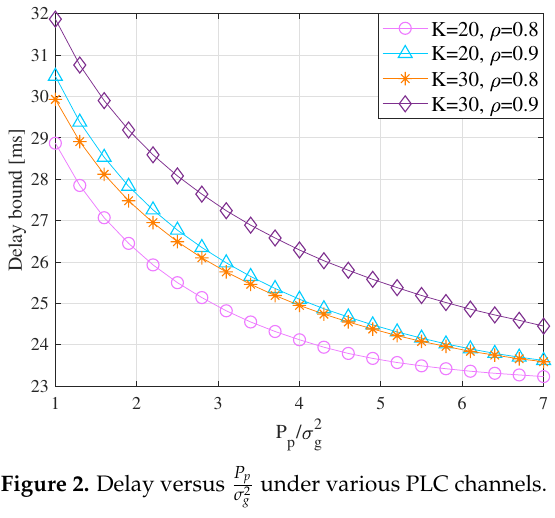
under various PLC σ 2 g